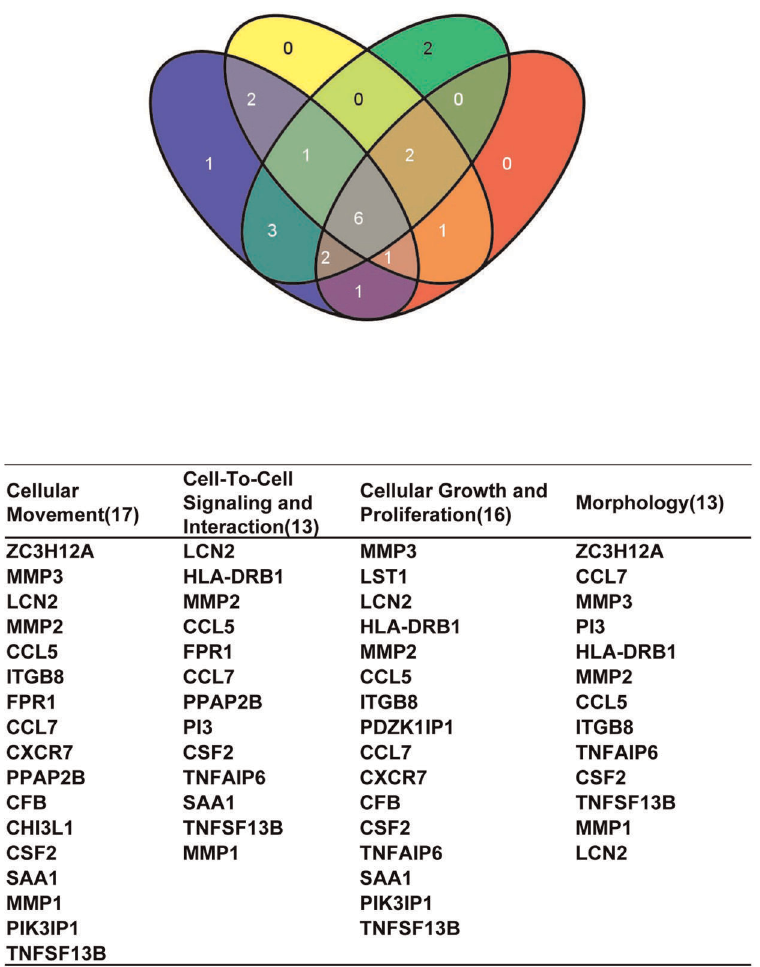
Figure 3. Venn diagram representing the number of transcripts related to biological functions, cellular movement, cell-to-cell signaling, cellular growth and proliferation and morphology for spheroids (3D) compared to monolayer (2D) NCI-H226 cells. Venn diagram incorporates 142 transcripts that have a p , 0.05 and at minimum a five-fold change between NCI-H226 spheroids and monolayer cells. Blue indicates 11 genes for cellular movement, yellow indicates 13 genes for cell-to-cell signaling and interaction, green indicates 16 genes for cellular growth and proliferation, and red indicates 13 morphology-related genes.